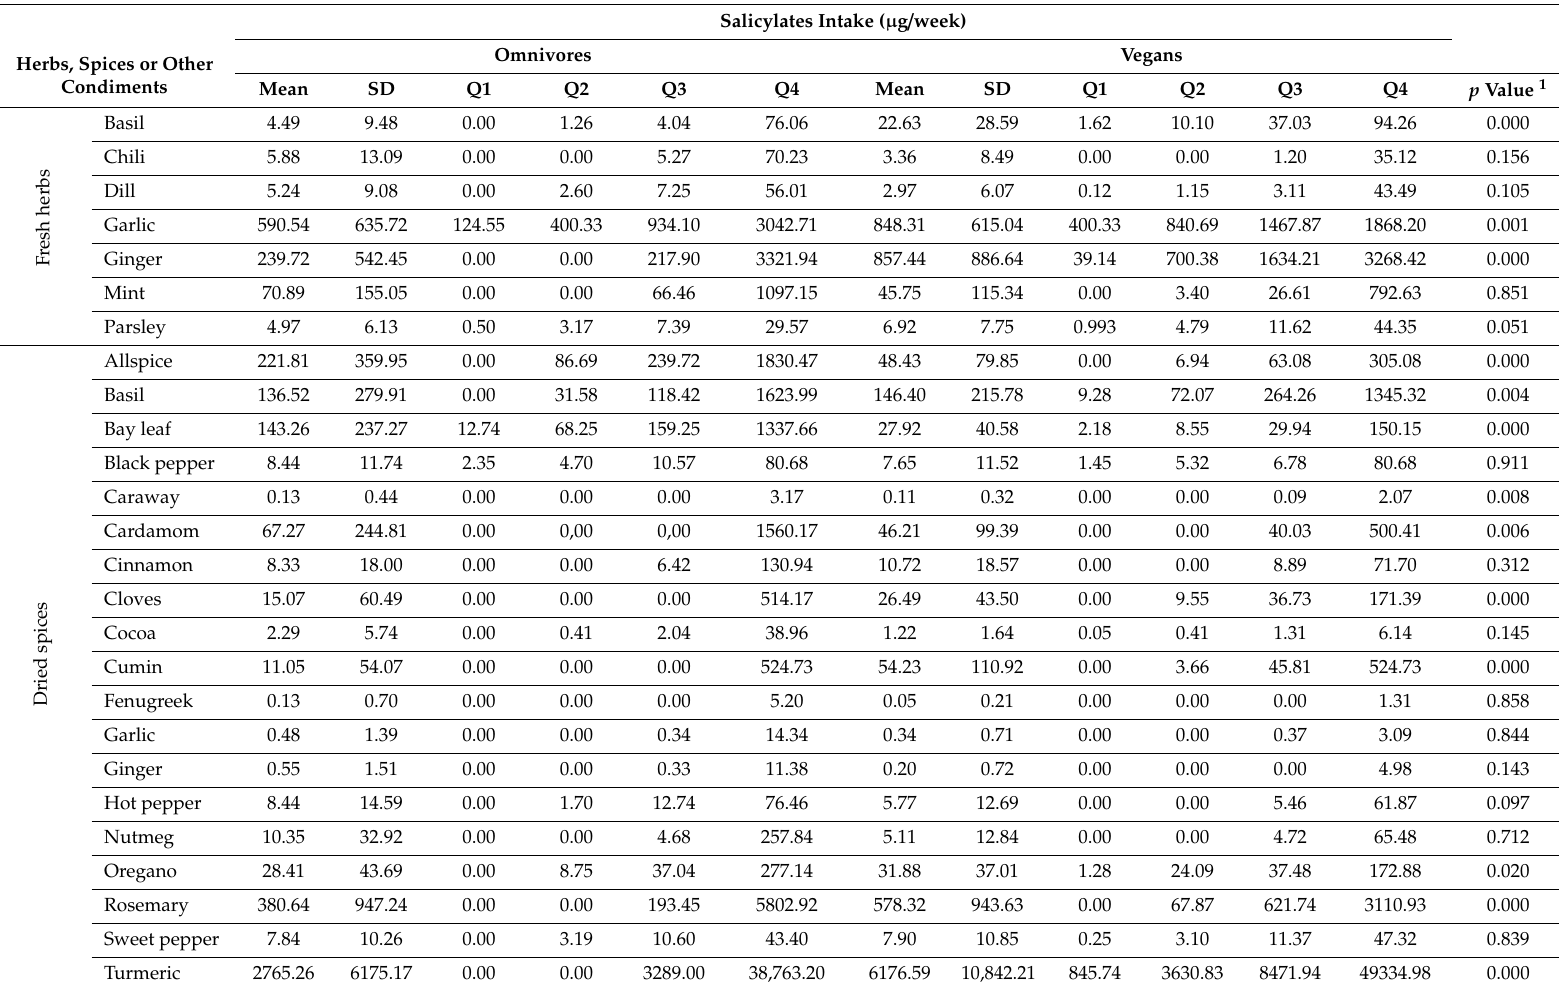
Table 8. Dietary salicylates intake from herbs, spices and other condiments among adult omnivores and